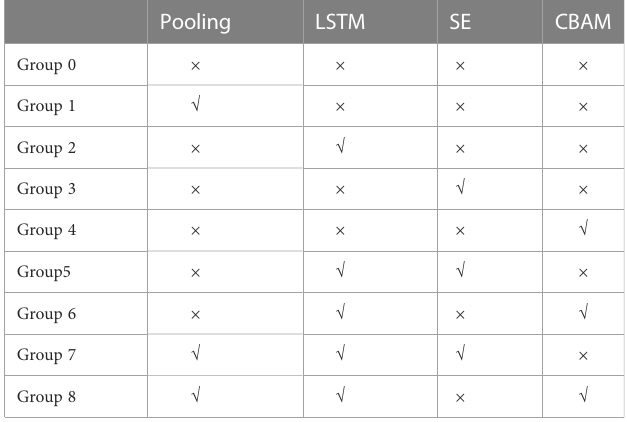
TABLE 2 Experimental group information for network structure